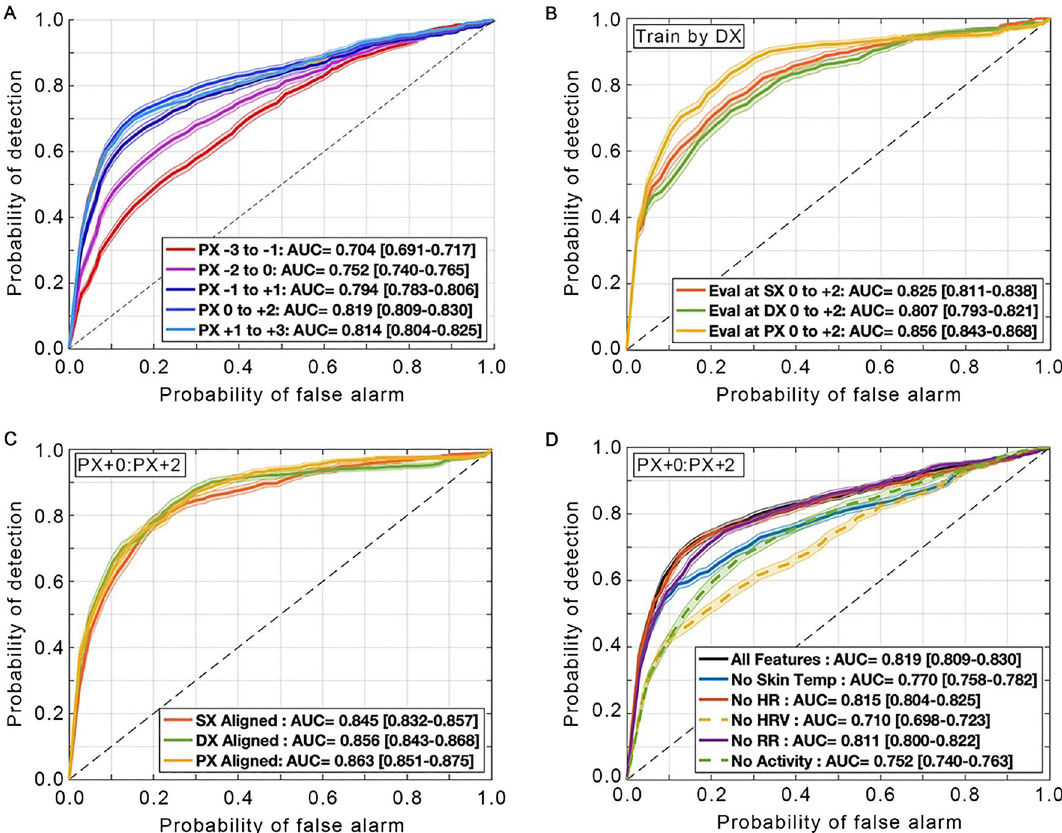
Figure 2. Algorithms aligned by PX can be used to classify COVID-19 infection. Each panel shows a set of receiver operator curves (ROC) with shading indicating ± 95% CI. PX = date of maximal change from average over the 21-day DX region; SX = date of onset of one of four core symptoms of COVID-19; DX = date of diagnostic testing for COVID-19; HR = heart rate, HRV = heart rate variability, and RR = respiratory rate. Numbers in relationship to PX, SX, and DX refer to number of days before (negative numbers) or after (positive numbers) each of these dates. Models trained by alignment to PX were more accurate as the evaluation window approached PX ( A ; from red pre-PX to blue post-PX; n = 73; in all cases, the number of negative training samples was 179,010; the number of positive training samples were: 8678, 9059, 9527, 9719, and 9705, respectively), with a peak accuracy at the window of PX + 0: PX + 2 days. ROC curves generated from models trained by alignment to DX performed best when evaluated relative to PX ( B ; n = 41, restricted to the subset of individuals with reliable symptom onset reports). Models trained by alignment to PX, SX, and DX performed comparably when evaluated at PX + 0: PX + 2 days ( C ; n = 41). Exclusion of any physiological measure lowers performance, with the ROC AUC dropping the most when HRV was omitted ( D; n =